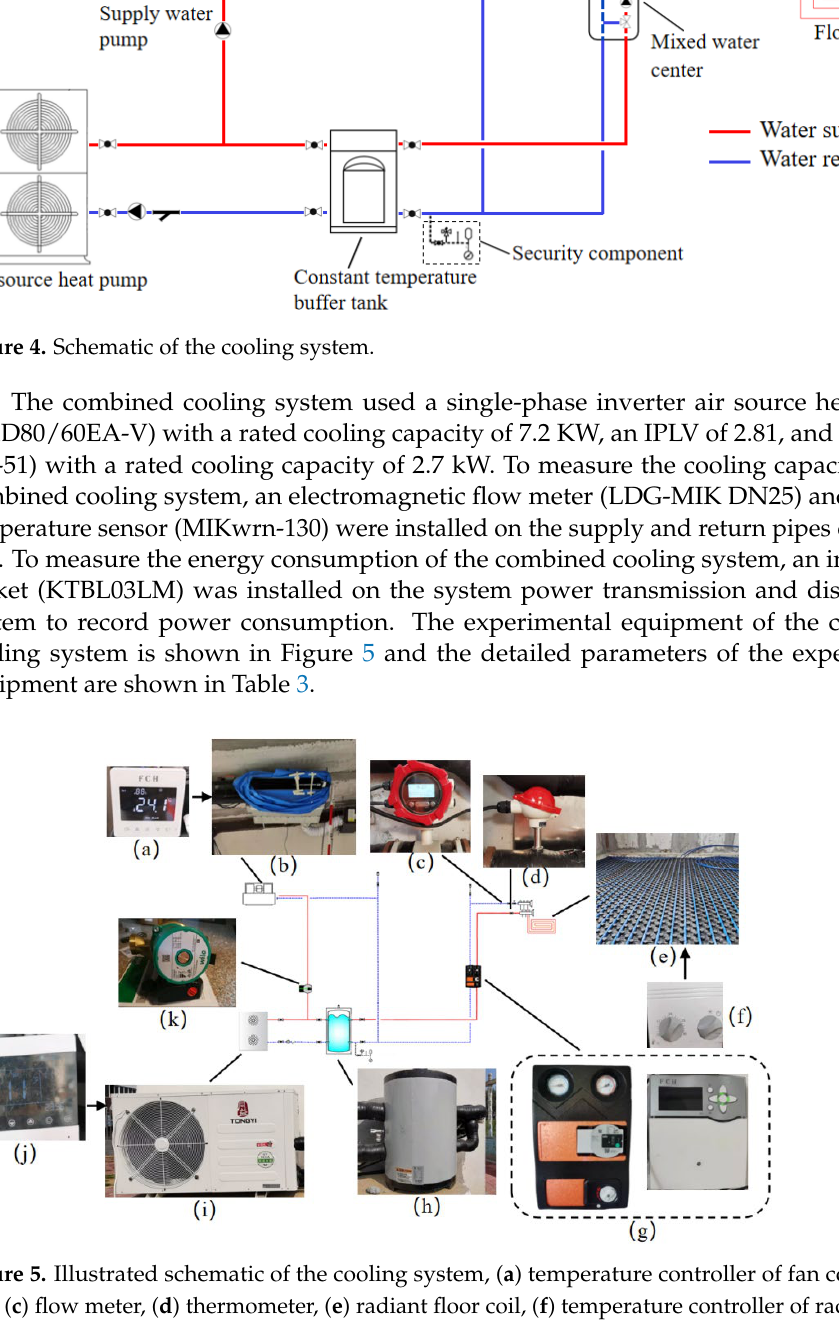
( g ) mixed water center, ( h ) constant temperature buffer tank, ( i ) air source heat pump, ( j ) controller